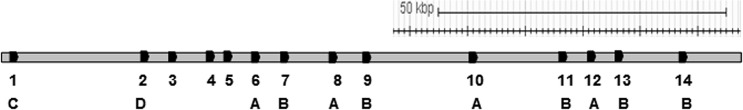
Schematic representation of the EgrCBF gene cluster on scaffold 1.The numbers correspond to EgrCBF1-14. The letters refer to EguCBF1A-, B-, C- or D-like, based on the percentage of identity between CBFs from E. grandis and E. gunnii (except for EgrCBF3, 4 and 5 unlabelled genes) (Table 3).